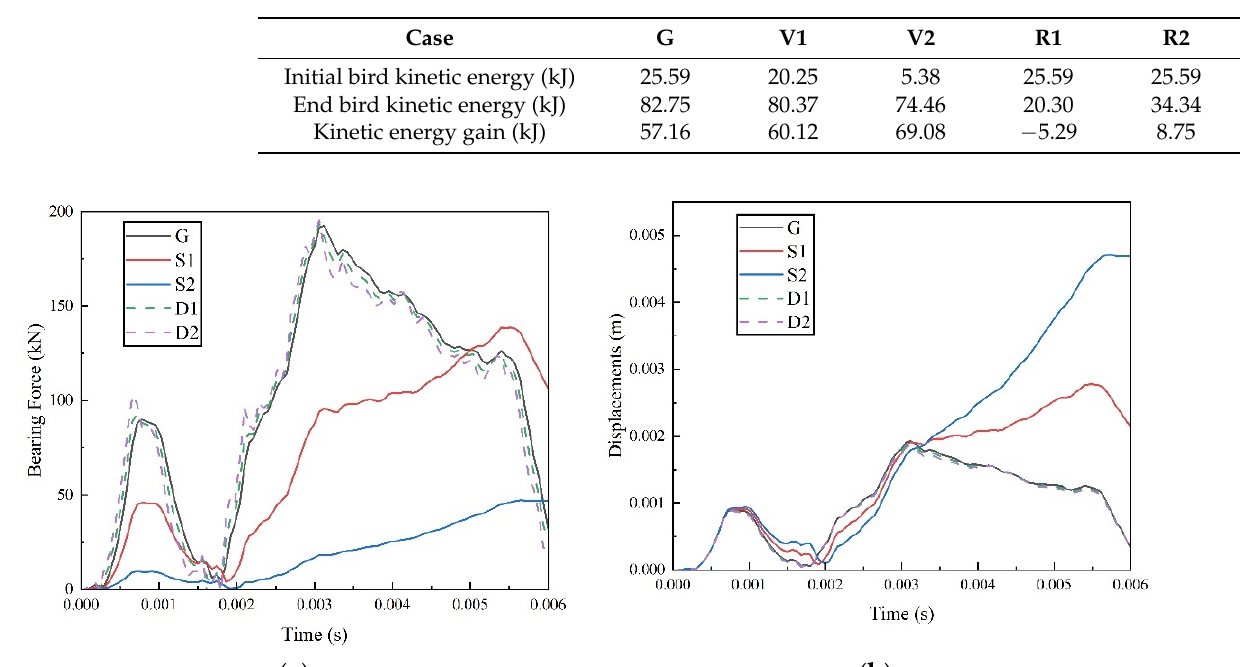
Table 7. The change in the kinetic energy for different initial velocities of the bird and different rotational speeds of the fan.